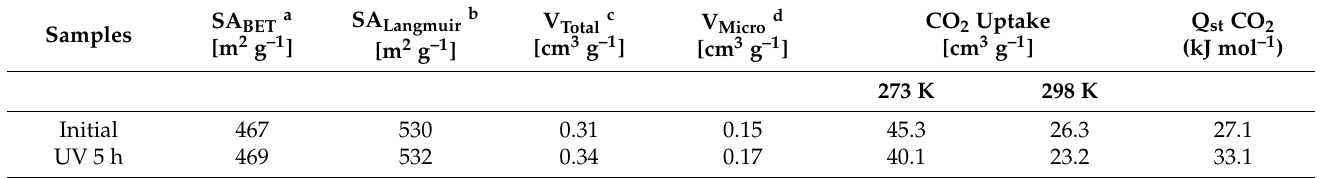
Table 1. Summary of porosity, pore volume and CO 2 adsorption properties for JJU-1.